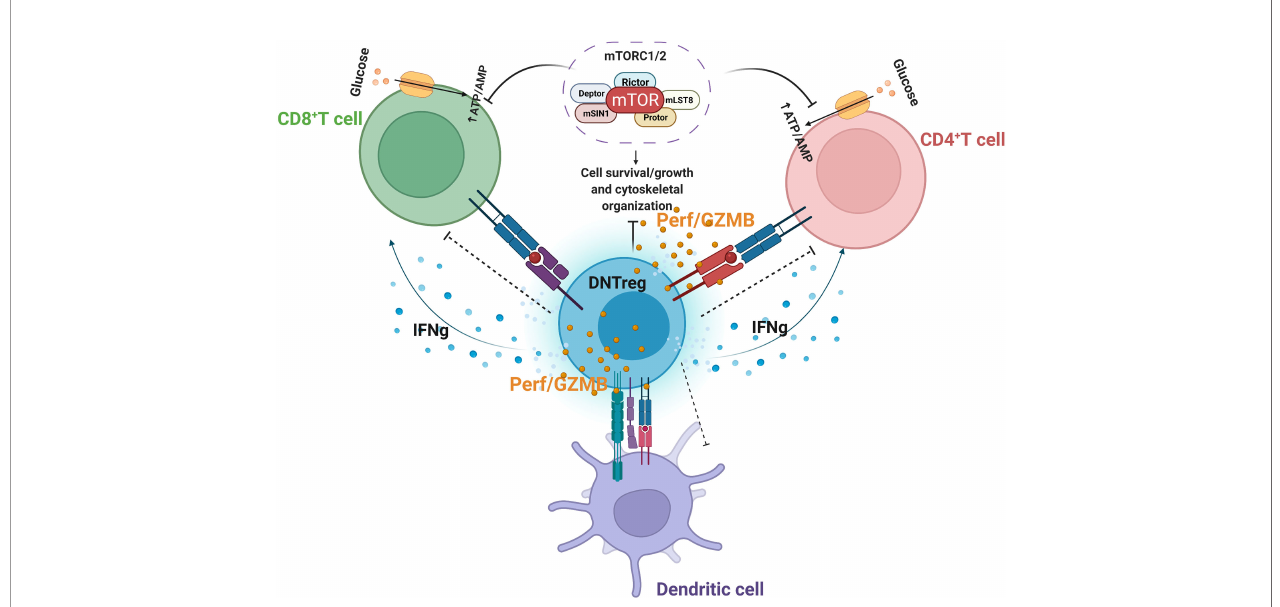
FIGURE 3 | Partial Model of DNTreg suppressor mechanisms. DNTregs can effectively suppress effector CD8 + , CD4 + T cells, and antigen-presenting cells through the antigen-speci fi c trogocytosis mechanism and release of cytolytic proteins, including selective inhibition of mTOR signaling. Perf = perforin; GZMB = granzyme (B) Figure created using Biorender.com .